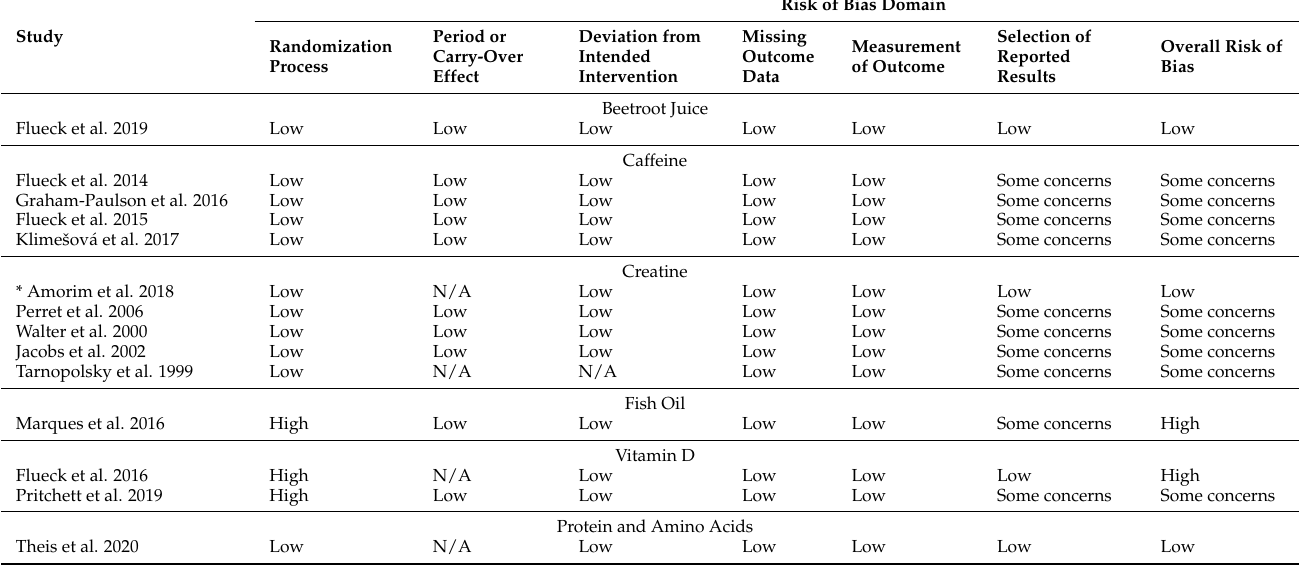
Table 2. Risk of Bias for Selected